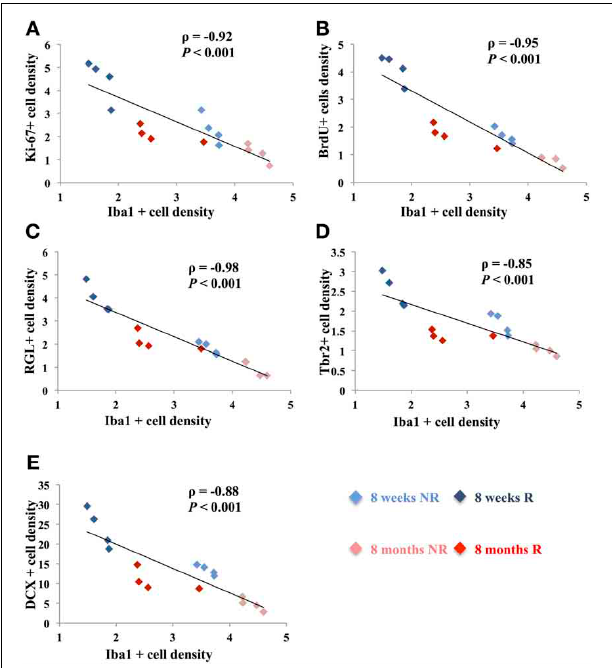
FIGURE 3 | Correlation between cell proliferation and Iba1-expressing microglia. (A–E) Plots showing the density of Ki-67-expressing cells (A) , BrdU-labeled cells (B) , RGL cells (C) , Tbr2-expressing cells (D) and DCX-expressing cells (E) , as a function of the density of Iba1-expressing cells, in the dentate gyrus. Each point represents the density of cells for one animal. Spearman’s correlation test was used to study the correlation, ρ : coefficient of Spearman; p : value of significance.